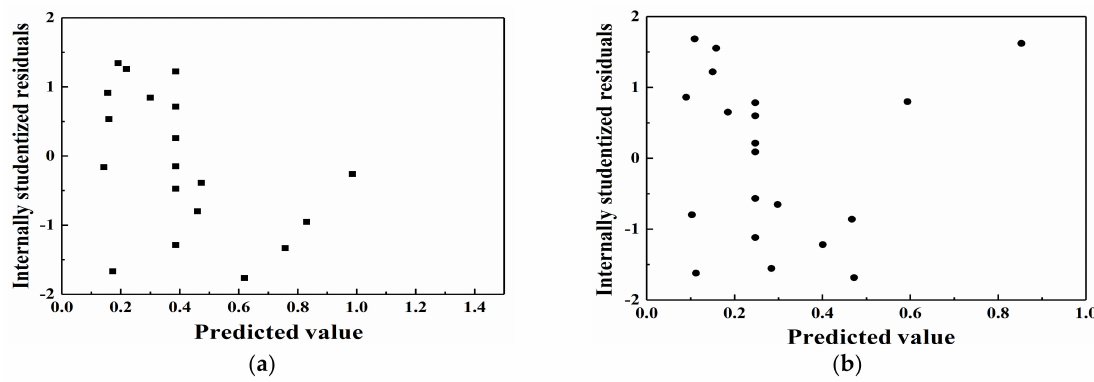
Figure 9. Distribution of the predicted values and internally studentized residuals: ( a ) A 1 and ( b ) A 2